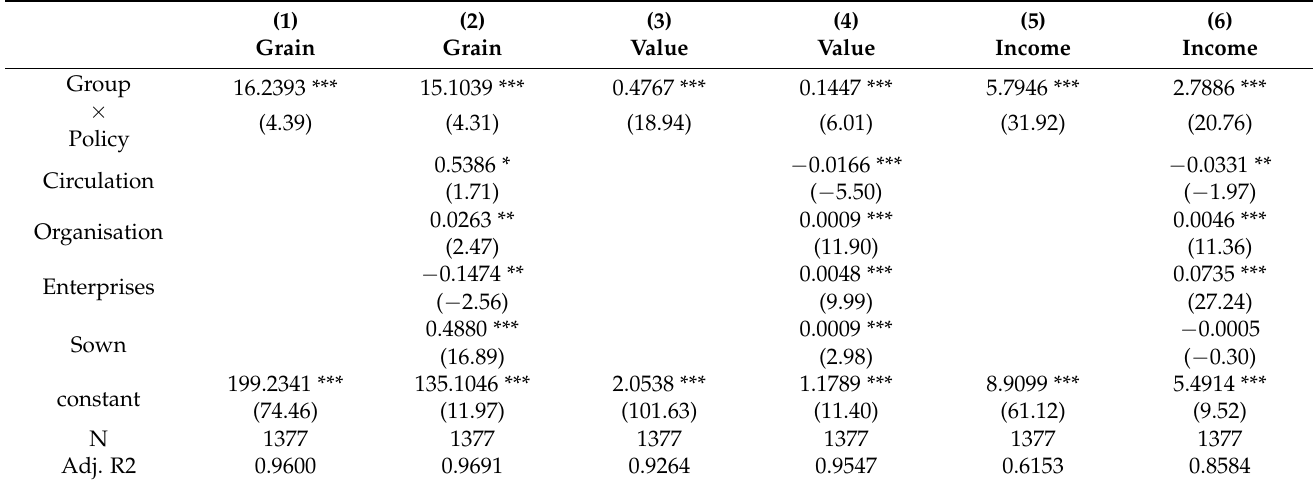
Table 4. Results of the DID benchmark regression analysis of rural